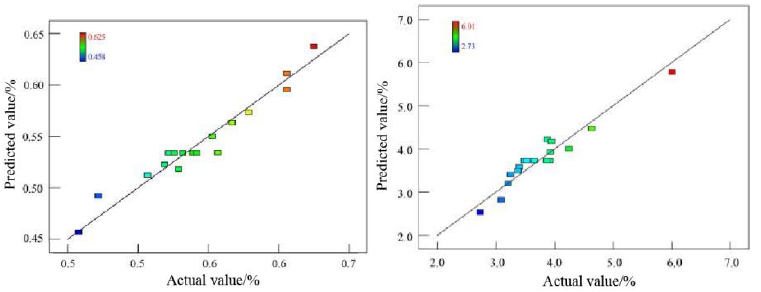
Figure 13. Relationship between the predicted value and actual value.